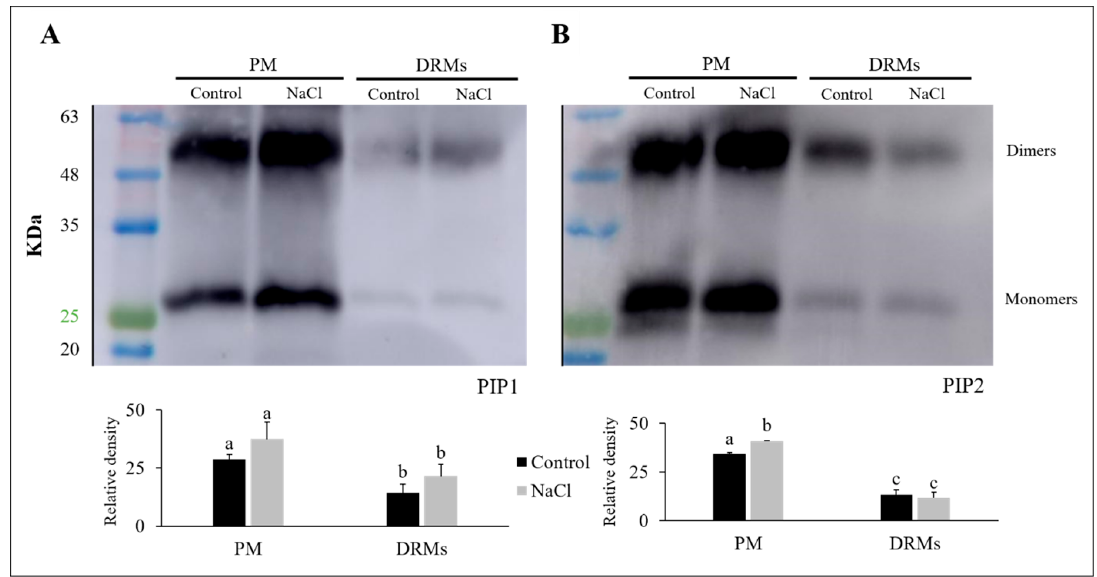
Figure 6. Immunodetection of PIP1 ( A ) and PIP2 ( B ) homologues in the root plasma membrane (PM) and detergent-resistant membranes (DRMs) of control broccoli plants and plants treated with 80 mM NaCl. Data are means ± SE ( n = 3). Analyses were done with three biological samples. Di ff erent letters represent significant di ff erences according to Tukey-HSD test ( p <